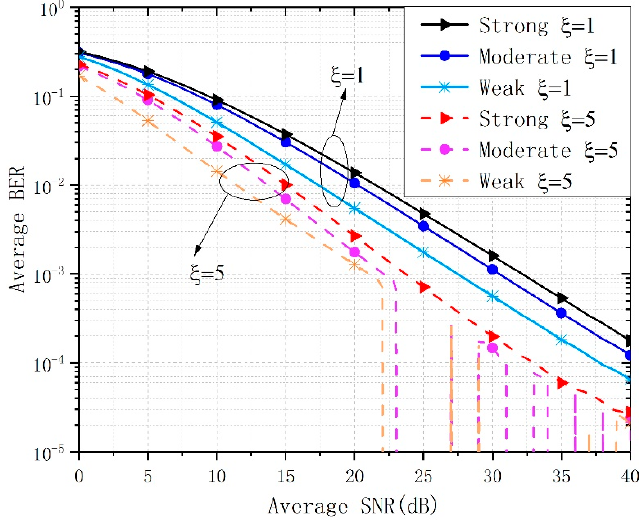
Figure 8. Average BER of 16PPM–BPSK–SIM against average SNR per hop for different turbulence strength and pointing error parameters. The fixed relay gain is C =